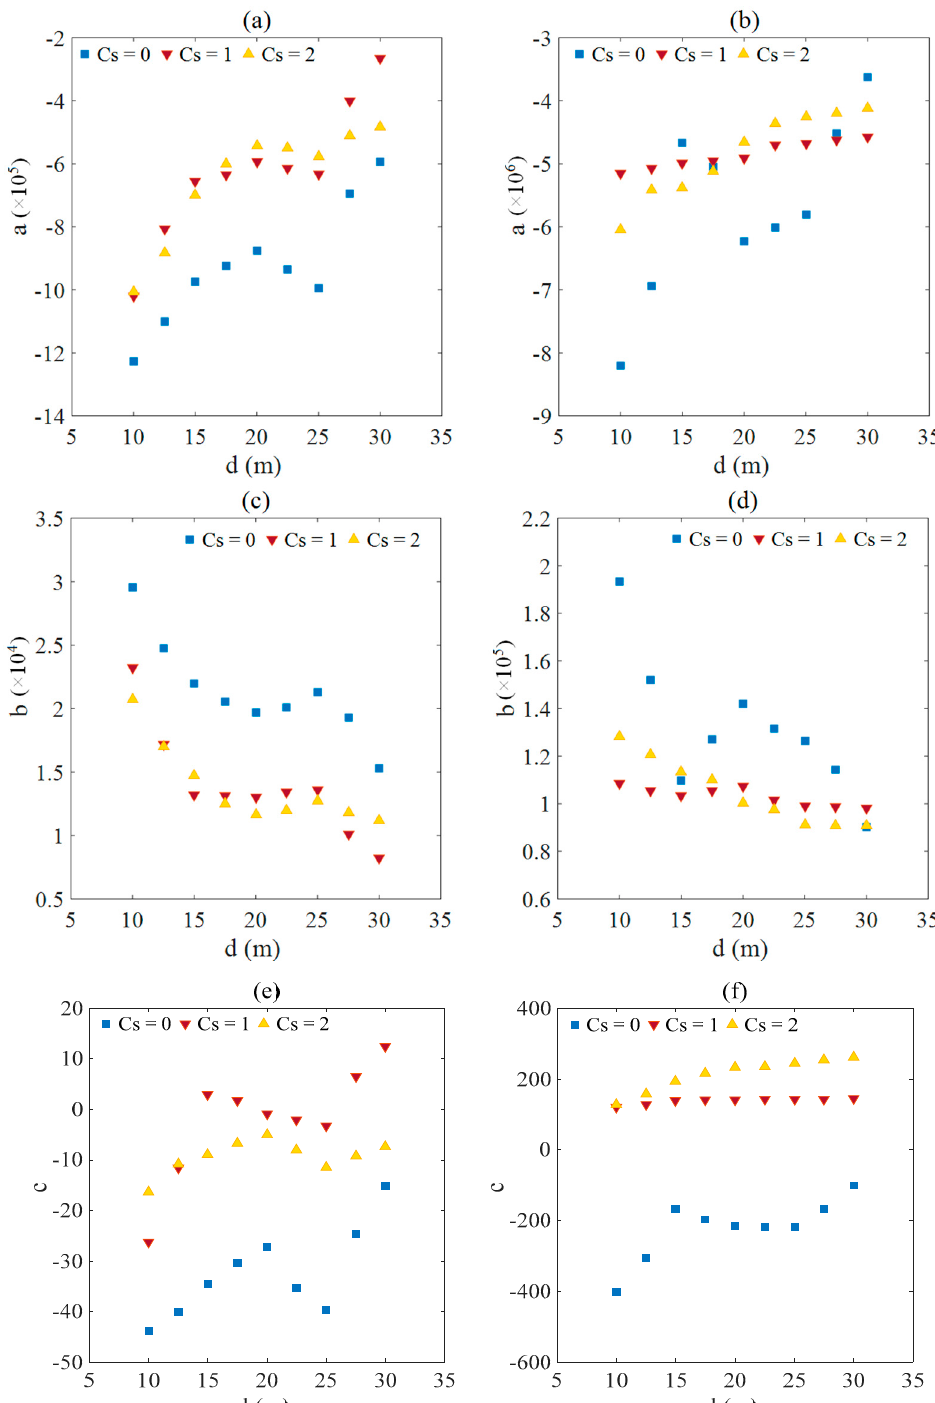
Figure 15. Distributions of coefficients a , b and c versus the water depth ( d ) for various submerged coefficient ( C s ). Here, ( a , b ) respectively represent the horizontal and vertical direction for coefficient a ; ( c , d ) respectively represent the horizontal and vertical direction for coefficient b ; ( e , f ) respectively represent the horizontal and vertical direction for coefficient c .